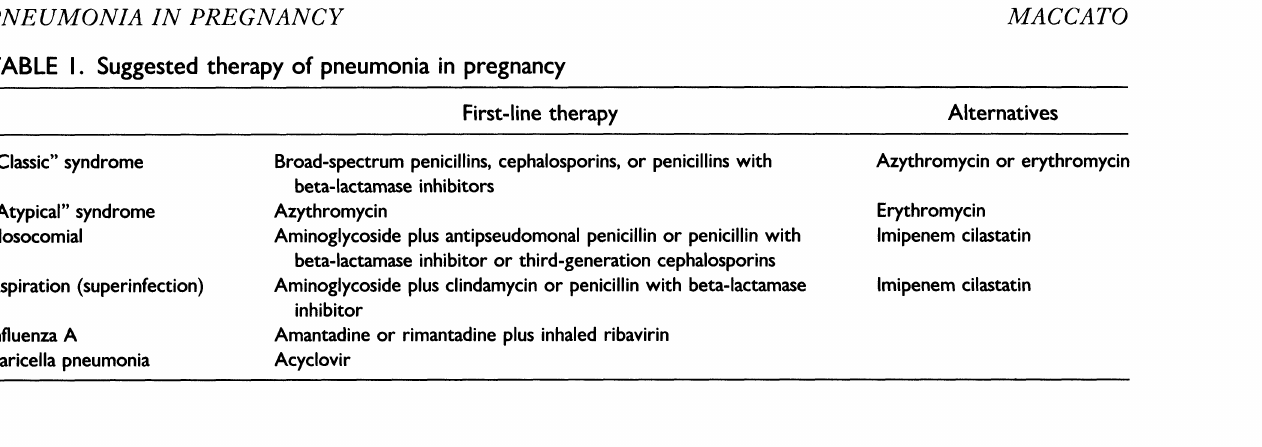
TABLE I. Suggested therapy of pneumonia in pregnancy